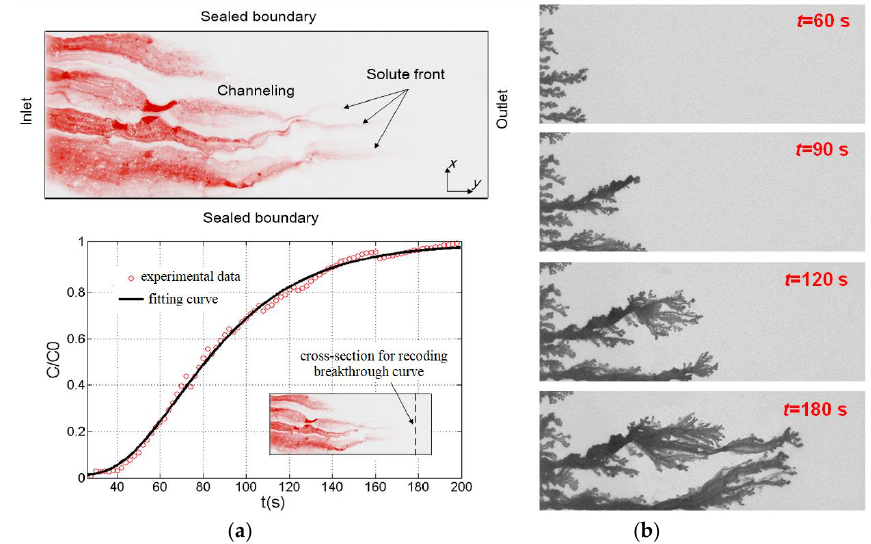
Figure 6. Experimental outcomes of solute migration and viscous fingering along a transparent rough fracture [52–56]: ( a ) Solute migration test and breakthrough curve; ( b ) developing process of viscous fingering.